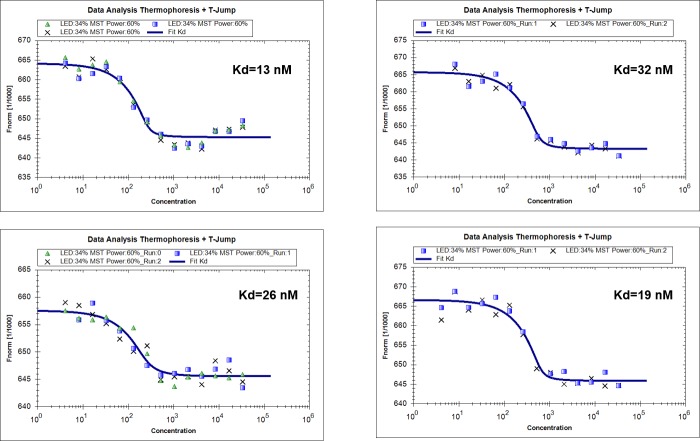
MST measurments of binding of RavZ(C258A) with MBP-LC3-PE (4 replicated experiments).